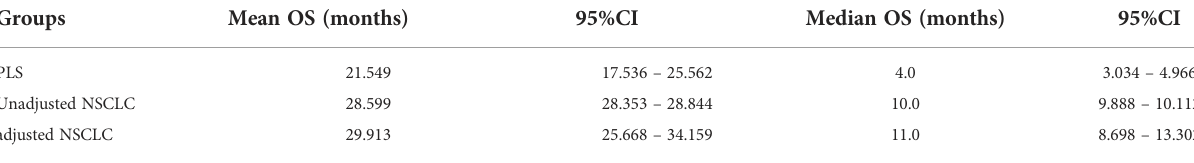
TABLE 4 Comparison of mean and median survival time between the PSC and NSCLC cohorts.